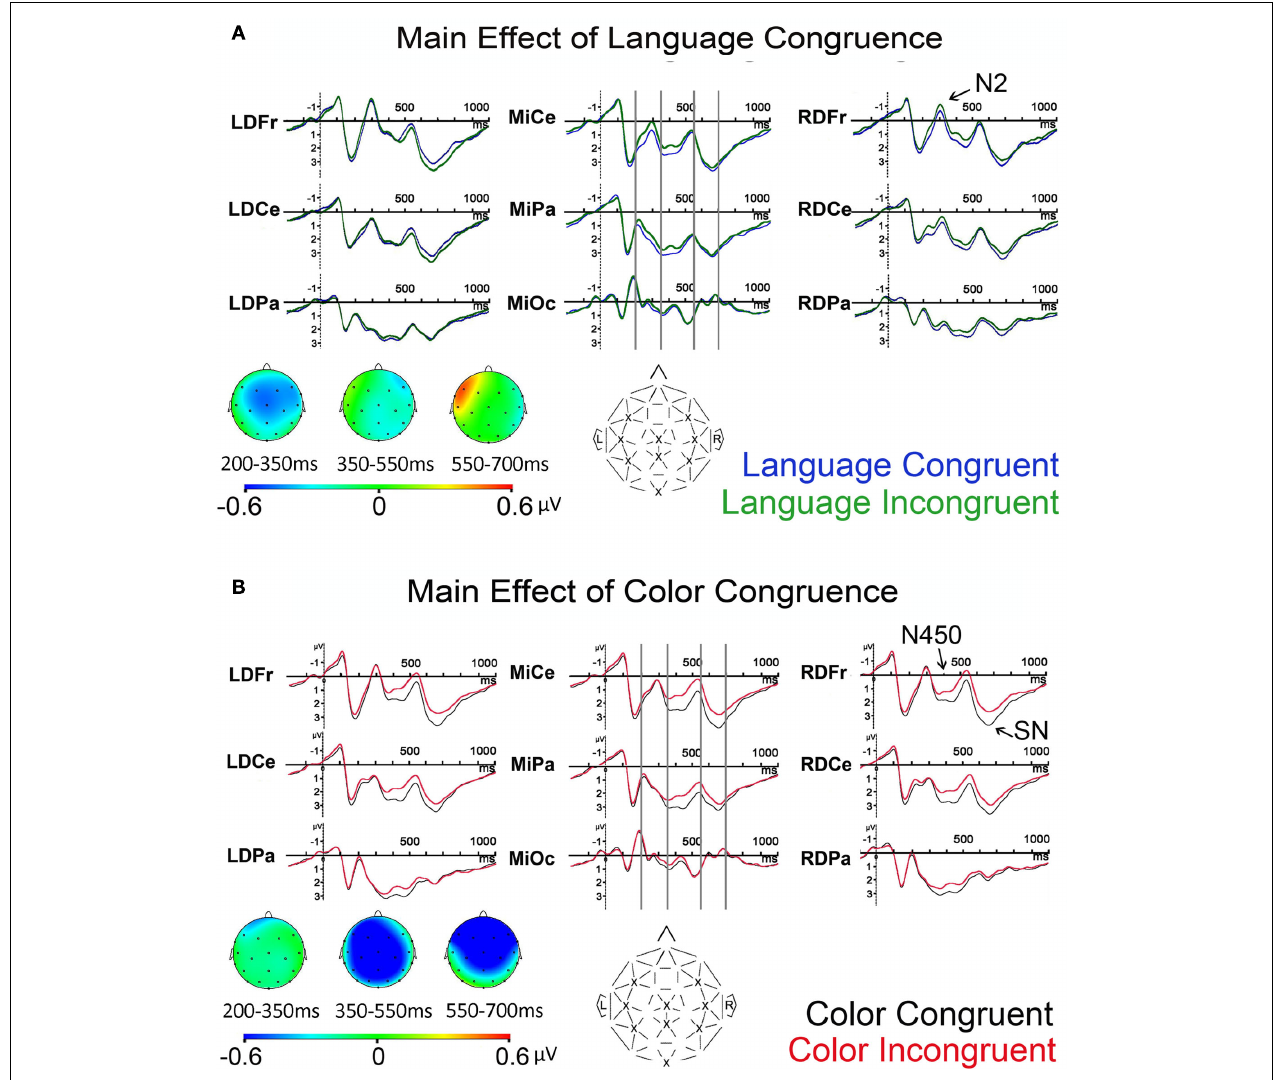
FIGURE 6 | Grand averageERPs for nine representative recording sites and spline-interpolated scalp topographies showing of three measured time windows for language congruence in (A) and color congruence in (B) (note that projection toward prefrontal channels is estimate). Vertical